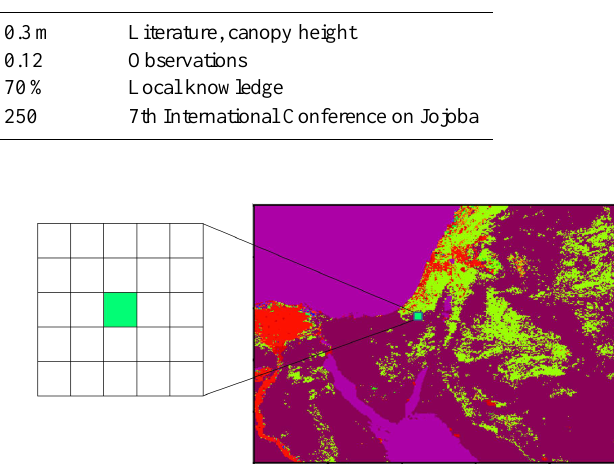
Fig. 6. Setup of the analysis of WRF output data. The image on the right is of the 20-category 30arcsecond MODIS land use data set, a static data set for model initialization (all 25 cells are classed as desert/scrub in the MODIS data). A 25 cell grid box (left panel) was used, over which all variables values were averaged spatially, prior to the calculation of temporal statistics. The centre grid cell, marked in green corresponds geographically to the location of the three surface stations. The 25 cell box (10 × 10km) was also used as a template for the simulated